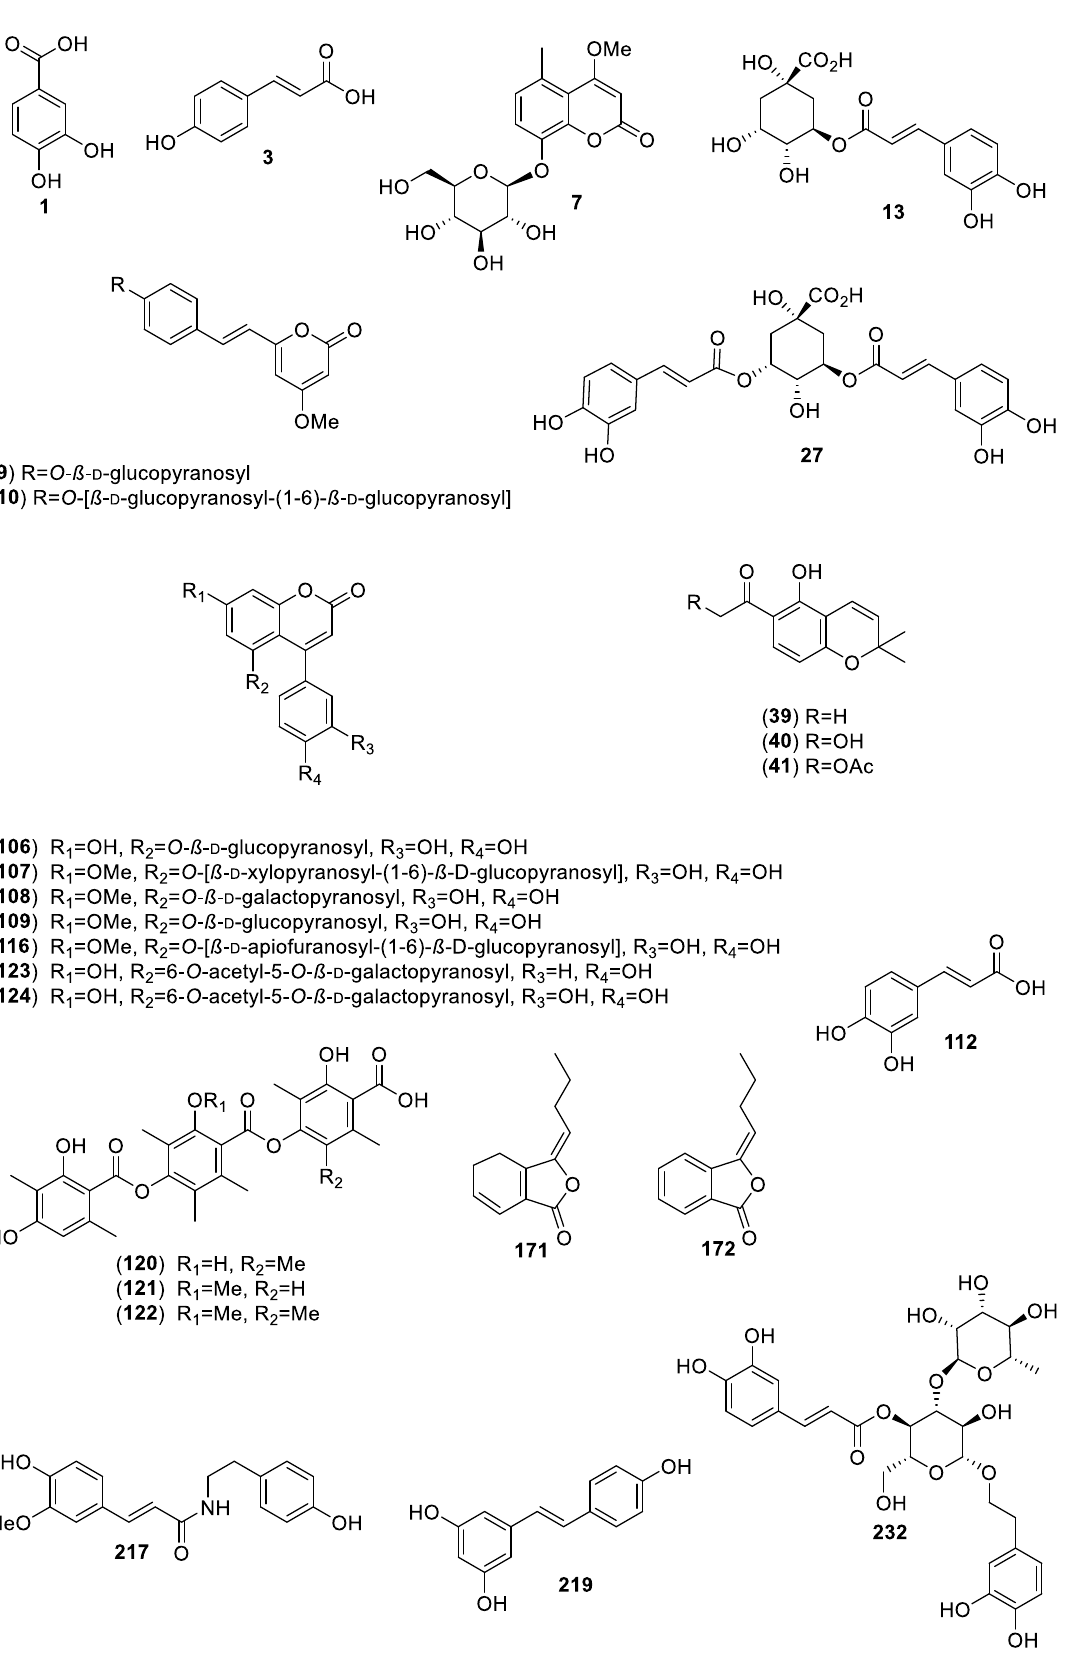
Figure 2. Aromatic compounds, other than flavonoids, from Mexican plants with hypoglycemic activity.